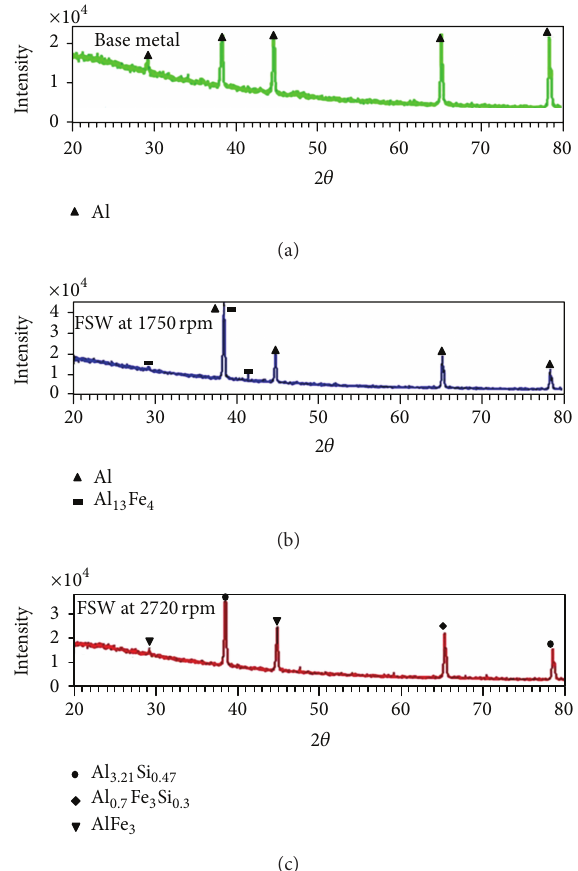
Figure 16: The microhardness profiles of Al-Al joints fabricated by